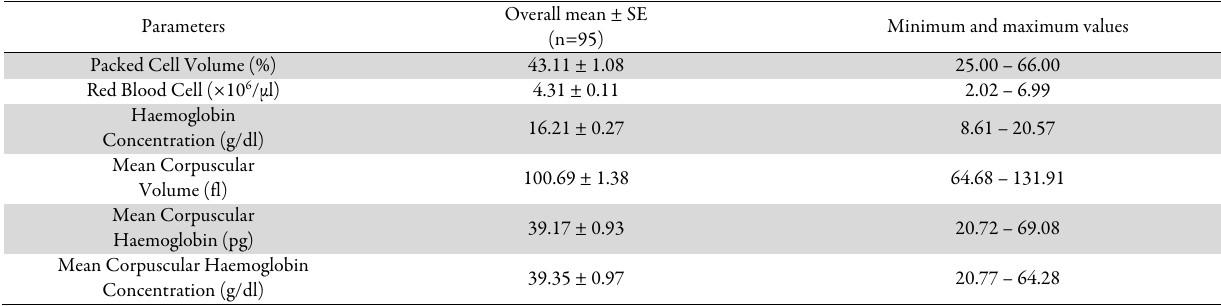
Table 1. The erythrocytic profile of adult Japanese quail ( Coturnix coturnix japonica )